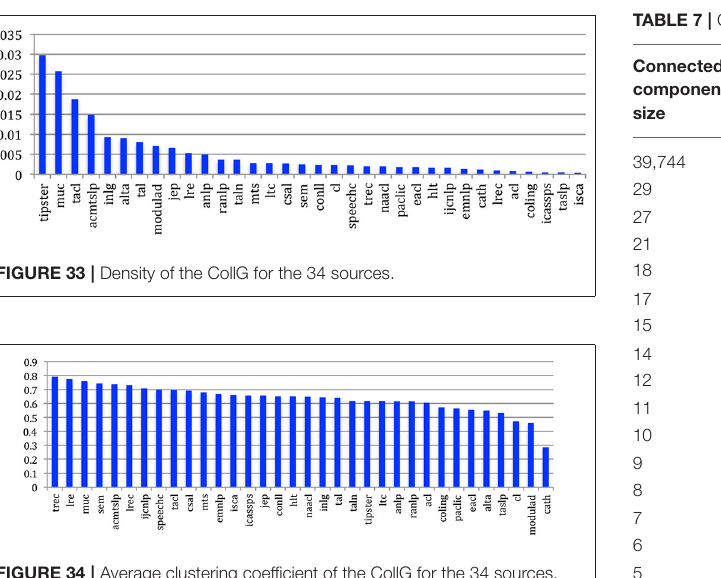
FIGURE 34 | Average clustering coefficient of the CollG for the 34 sources.